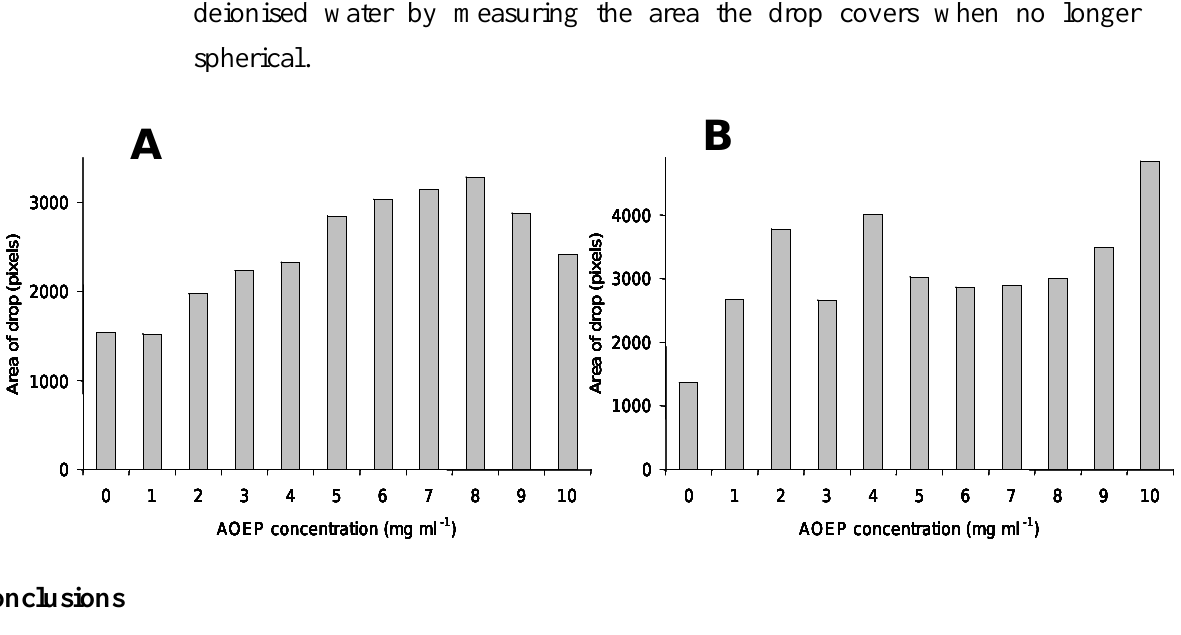
Figure 2. Drop spreading test of 2-acyloxyethylphosphonate (AOEP) isolated from waterblooms of Aphanizomenon floa-aquae . The drop spreading test was used to measure the effectiveness of AOEP dissolved in deionised water (Figure 2A) or methanol (Figure 2B) at reducing the surface tension of a drop of deionised water by measuring the area the drop covers when no longer